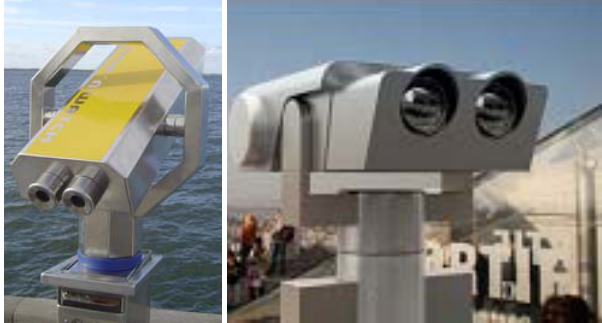
Fig. 2. (left) Traditional toursitic Telescope. (right) First design of the Telescope.